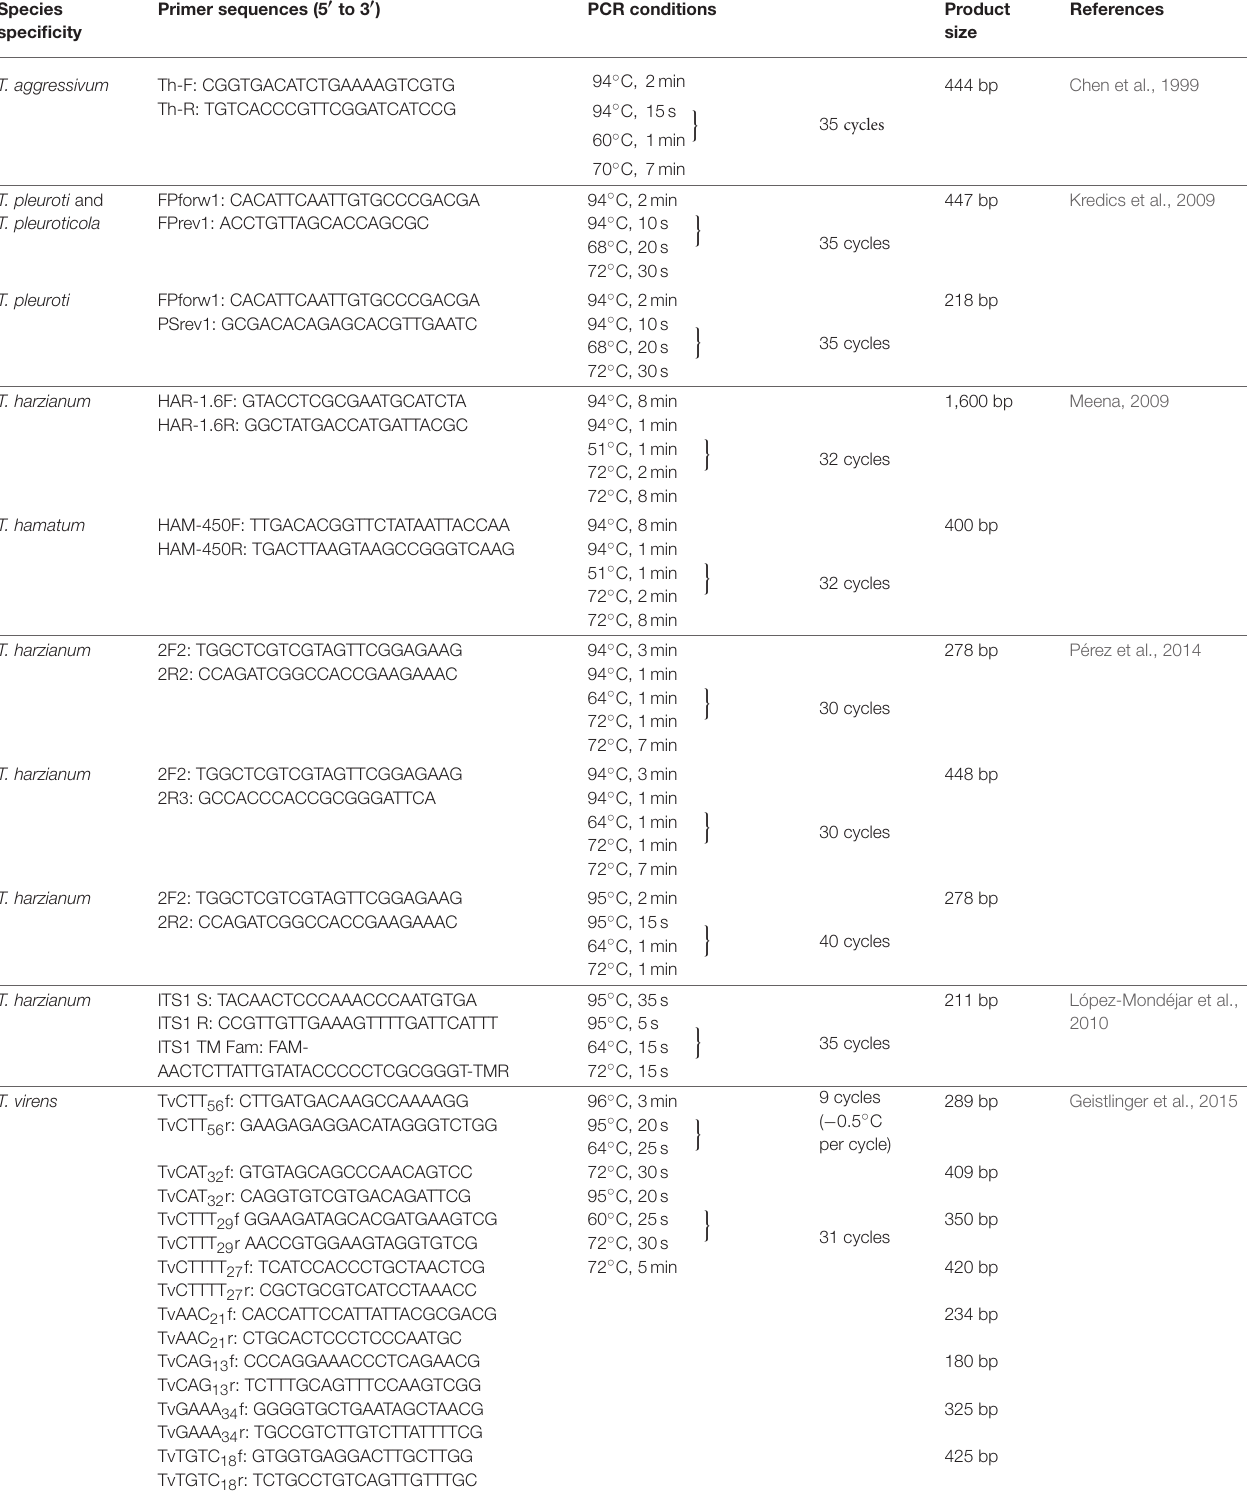
TABLE 1 | Examples of species-specific PCR protocols for Trichoderma